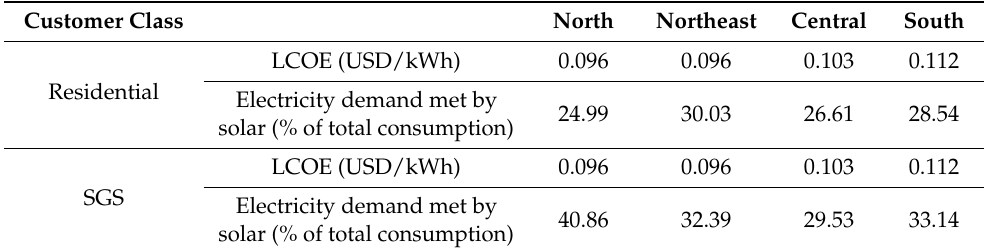
Table 2. Average LCOE and level of PV generation supplied to load by region for residential and SGS customers.